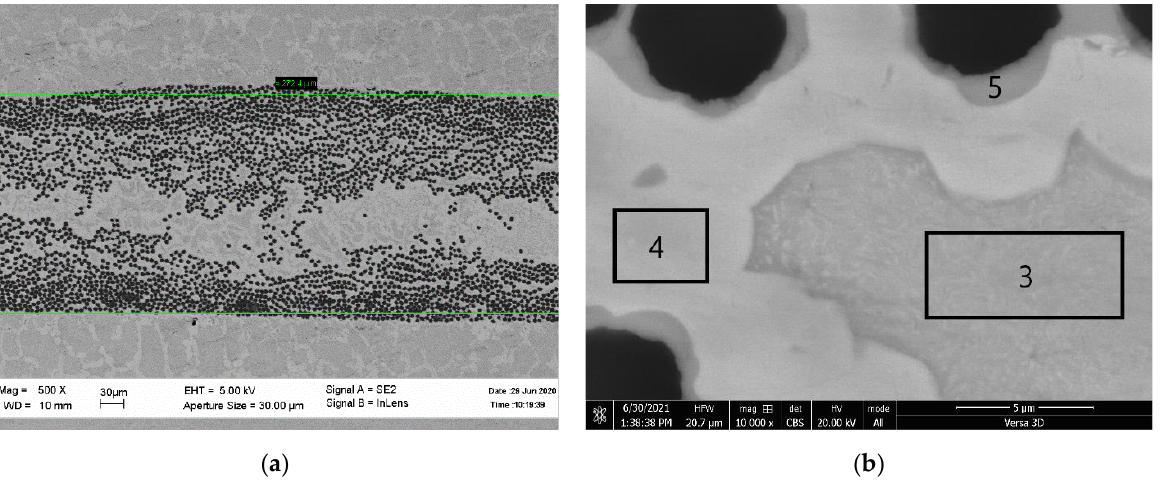
Figure 19. SEM microphotographs of the cross-section of cabon-fibre ( a )/titanium-matrix compo-sites ( b ).